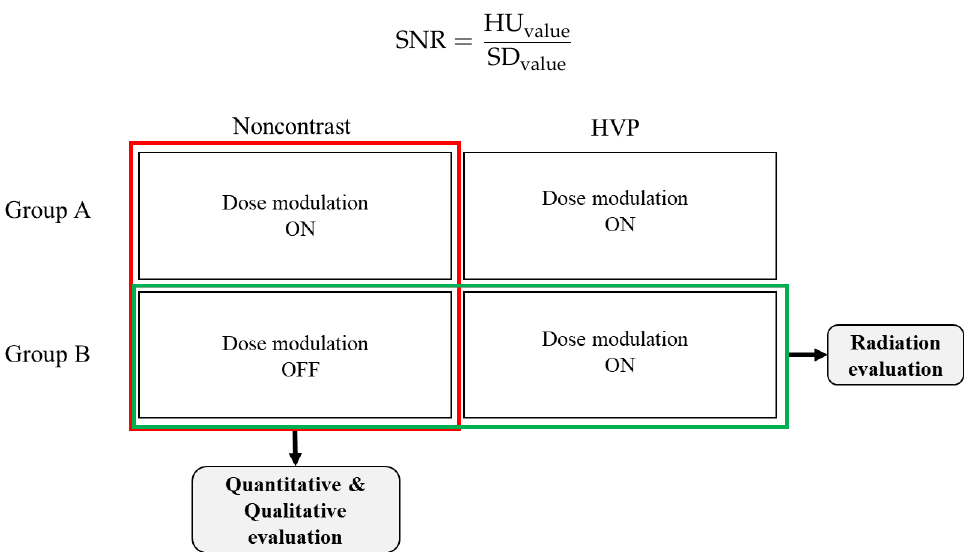
Figure 1. Schematic diagram of study design showing the comparison target for quantitative, qualitative, and radiation dose evaluation.